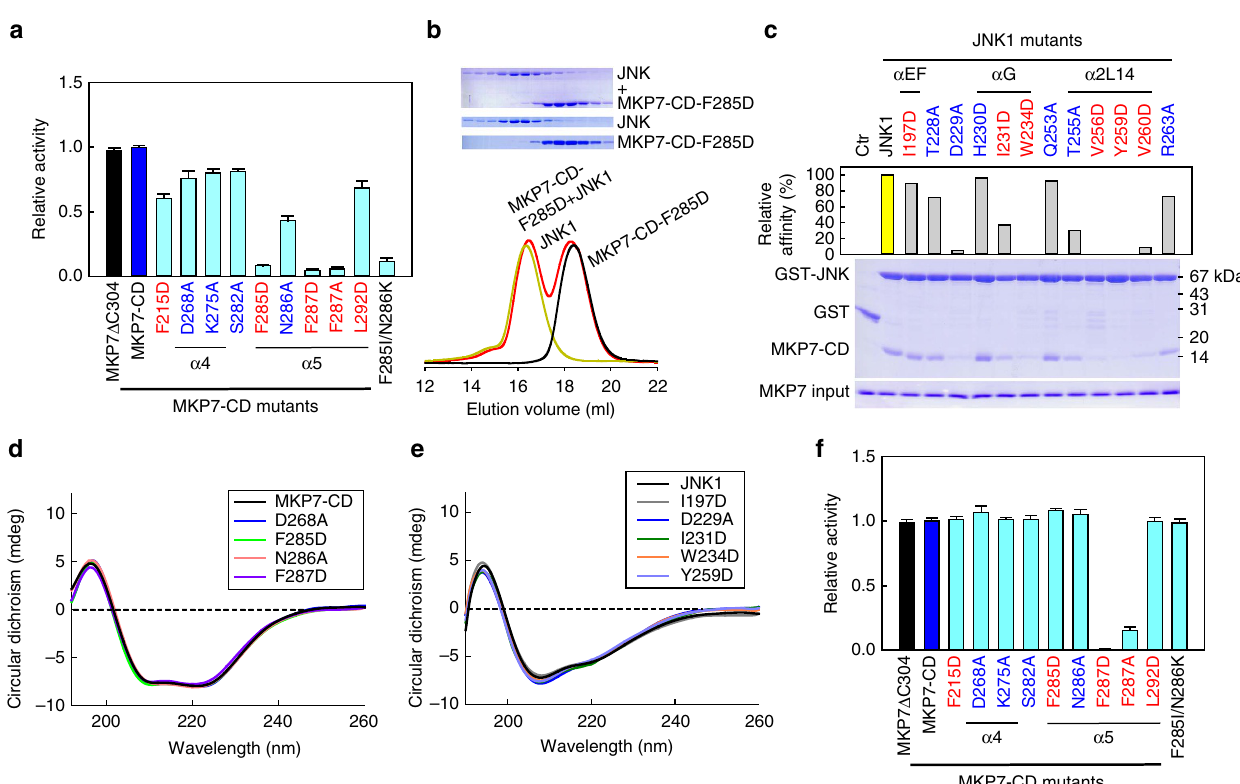
Figure 4 | Mutational analysis on interactions between MKP7-CD and JNK1. ( a ) Effects of mutations in MKP7-CD on the JNK1 dephosphorylation (mean ± s.e.m., n ¼ 3). Residues involved in hydrophobic and hydrophilic contacts are coloured in red and blue, respectively. ( b ) Gel filtration analysis for interaction of JNK1 with MKP7-CD mutant F285D. Mutant F285D and JNK1 were eluted as monomers, with the molecular masses of B 17 and 44kDa, respectively. However, in contrast to the wild-type MKP7-CD, mutant F285D did not co-migrate with JNK1. ( c ) Pull-down assays of MKP7-CD by GST-tagged JNK1 mutants. The top panel shows the relative affinities of MKP7-CD to JNK1 mutants, with the affinity of wild-type JNK1 defined as 100%, the middle panel is the electrophoretic pattern of MKP7-CD and JNK1 mutants after GST pull-down assays. The protein amounts of MKP7-CD used are shown at the bottom. ( d ) Circular dichroism spectra for MKP7-CD wild type and mutants. Measurements were averaged for three scans. ( e ) Circular dichroism spectra for JNK1 wild type and mutants. Measurements were averaged for three scans. ( f ) Effects of mutations in MKP7-CD on the p NPP hydrolysis reaction (mean ± s.e.m., n ¼